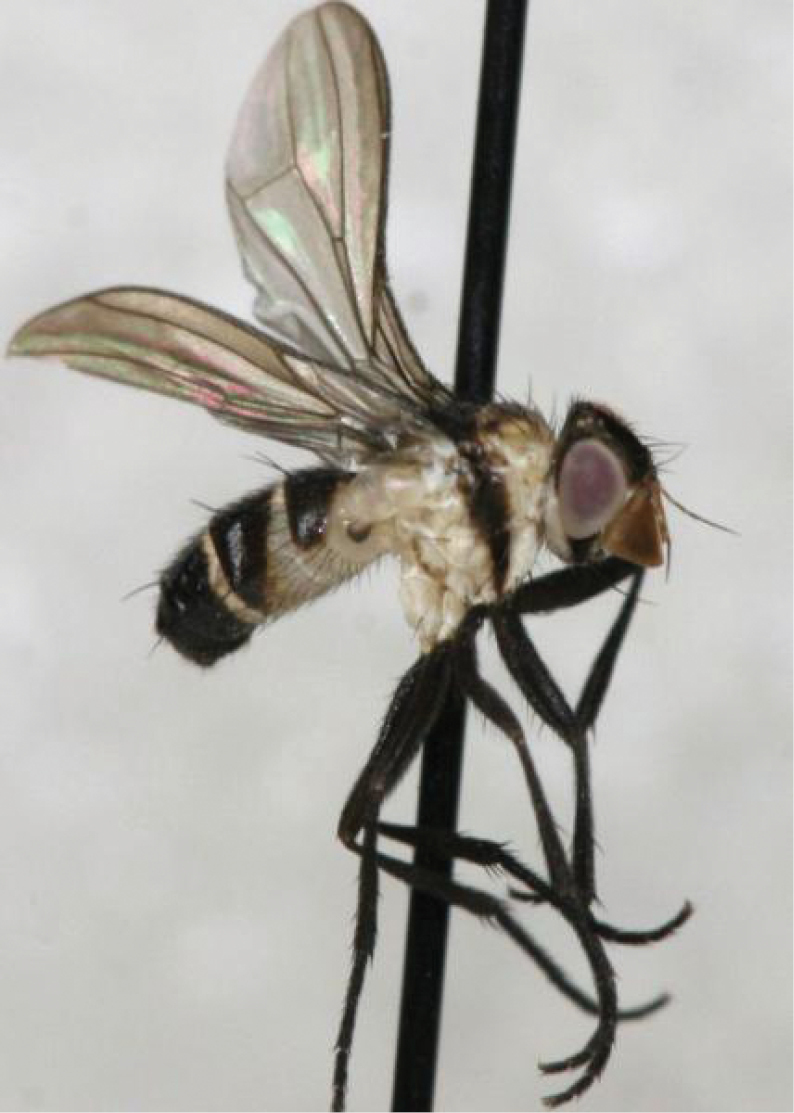
Kinabalumyia sp. 2, undescribed species from Indonesia, Bali (ZMUM).